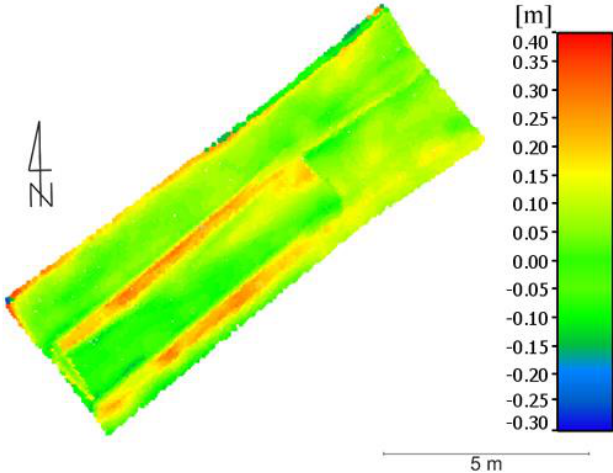
Figure 22. Distribution of differences in the height of the point cloud in relation to the reference model (Test Area No. 4).